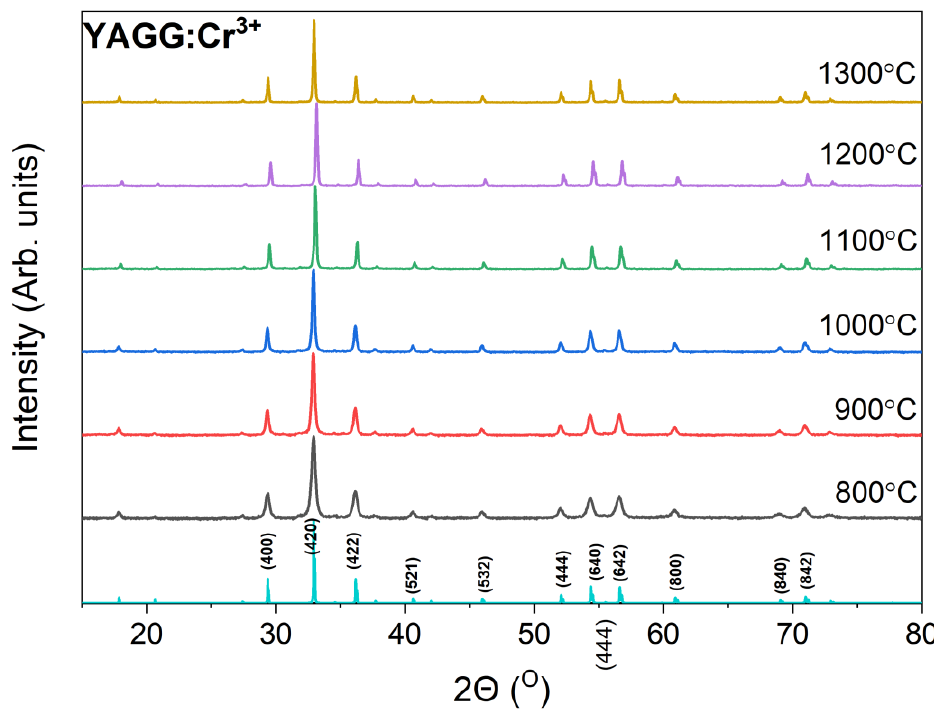
Figure 1. XRPD pattern of the YAGG:Cr 3+ nanopowders annealed at different temperatures.